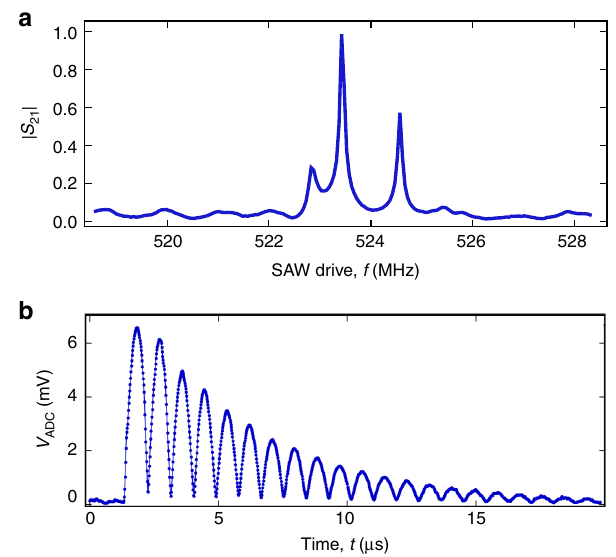
Fig. 2 SAW cavity response. a Normalised linear magnitude of the measured transmission coef fi cient S 21 of the 2-port SAWR (blue solid line). The transmitted signal has been acquired with a vector network analyser with input power set at − 30 dBm. b Time resolved measurement of the 2- port SAWR. This measurement has been performed by applying a 800ns ≲ 2 L v c / e electrical pulse to IDT 1 and acquiring the output signal from IDT 2 . The graph shows the voltage difference at the input of the acquisition